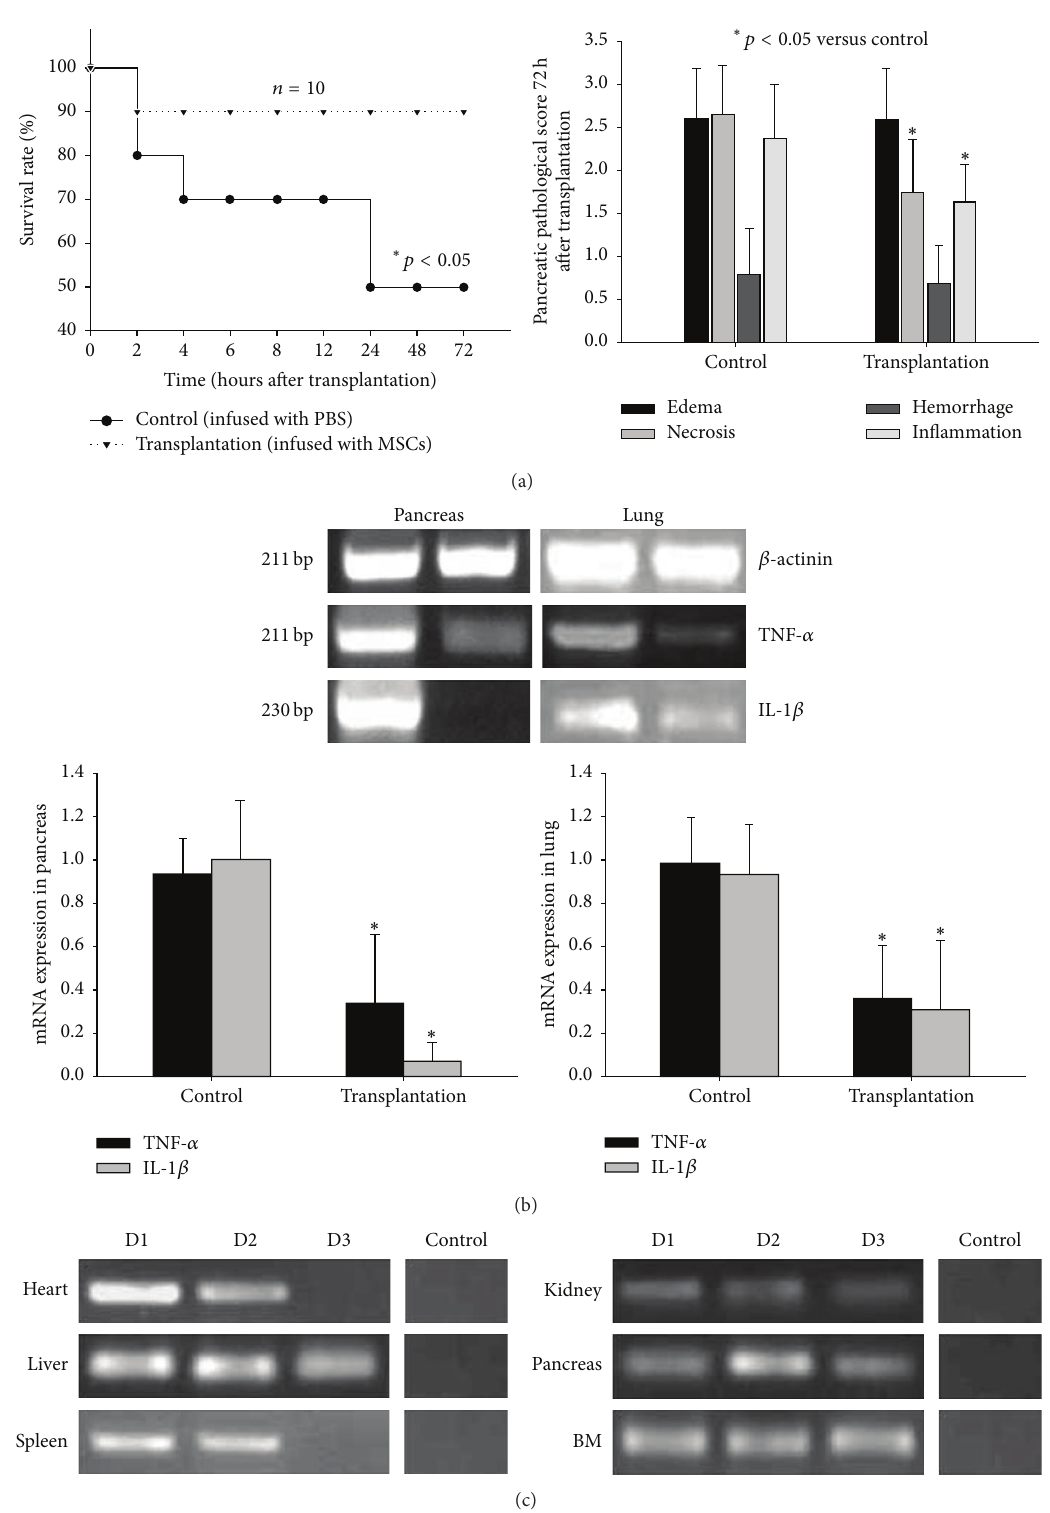
Figure 4: (a) The survival rate of the MSC transplantation group was significantly higher than that of control group ( ∗ 𝑝 < 0.05 ). The survival rate of control group treated with PBS was 50%, while the survival rate of the transplantation group treated with MSCs was 90%. After MSC transplantation, pancreatic pathological scores of necrosis and inflammation decreased significantly ( ∗ 𝑝 < 0.05 ). (b) Detection of expression of TNF- 𝛼 and IL-1 𝛽 mRNA in the pancreas and lungs of control and transplantation groups 72 h after MSC infusion by semiquantitative and real-time RT-PCR. The expression of TNF- 𝛼 and IL-1 𝛽 in the pancreas and lungs was significantly lower in MSC transplantation group than in control group ( ∗ 𝑝 < 0.05 ). (c) Detection of SRY fragment 3 days after MSC transplantation in multiple